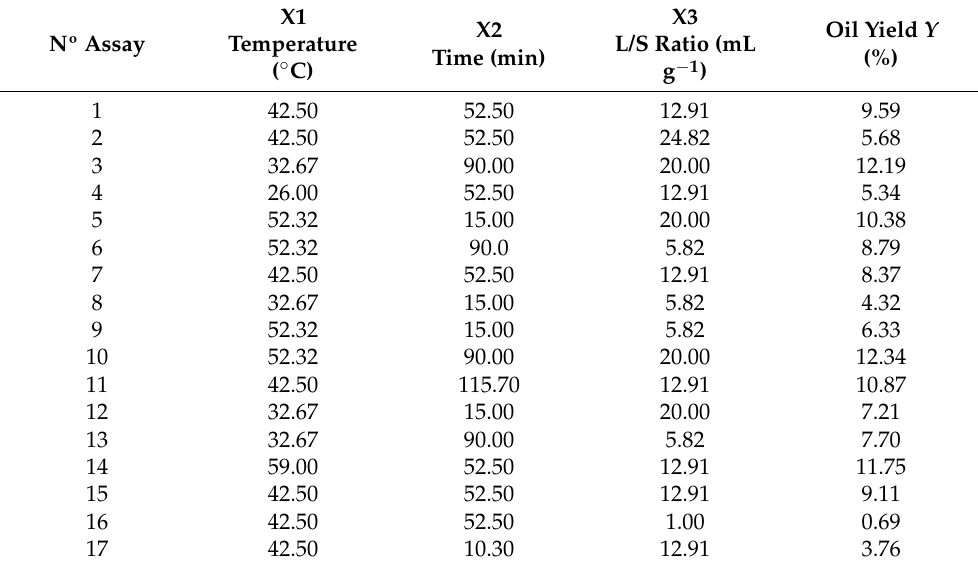
Table 3. Experimental assays conditions and oil yield for the n-hexane extraction of SCG